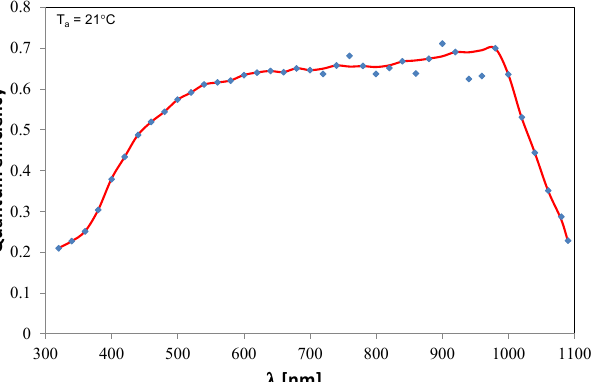
Figure 6. The measured dependence of the external quantum efficiency of the investigated solar cell on λ in room temperature.